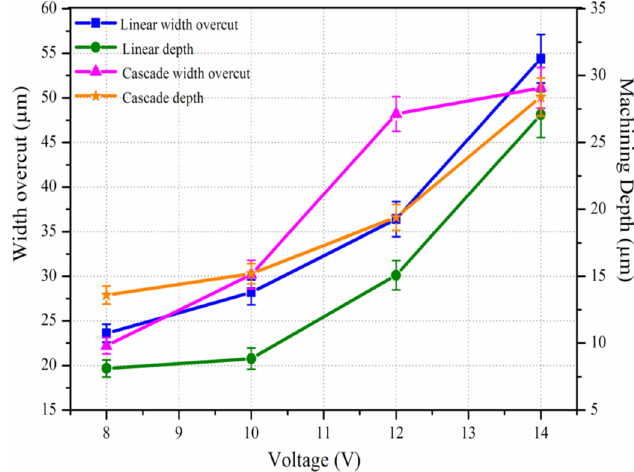
Fig. 3. Effect of machining voltage on width overcut